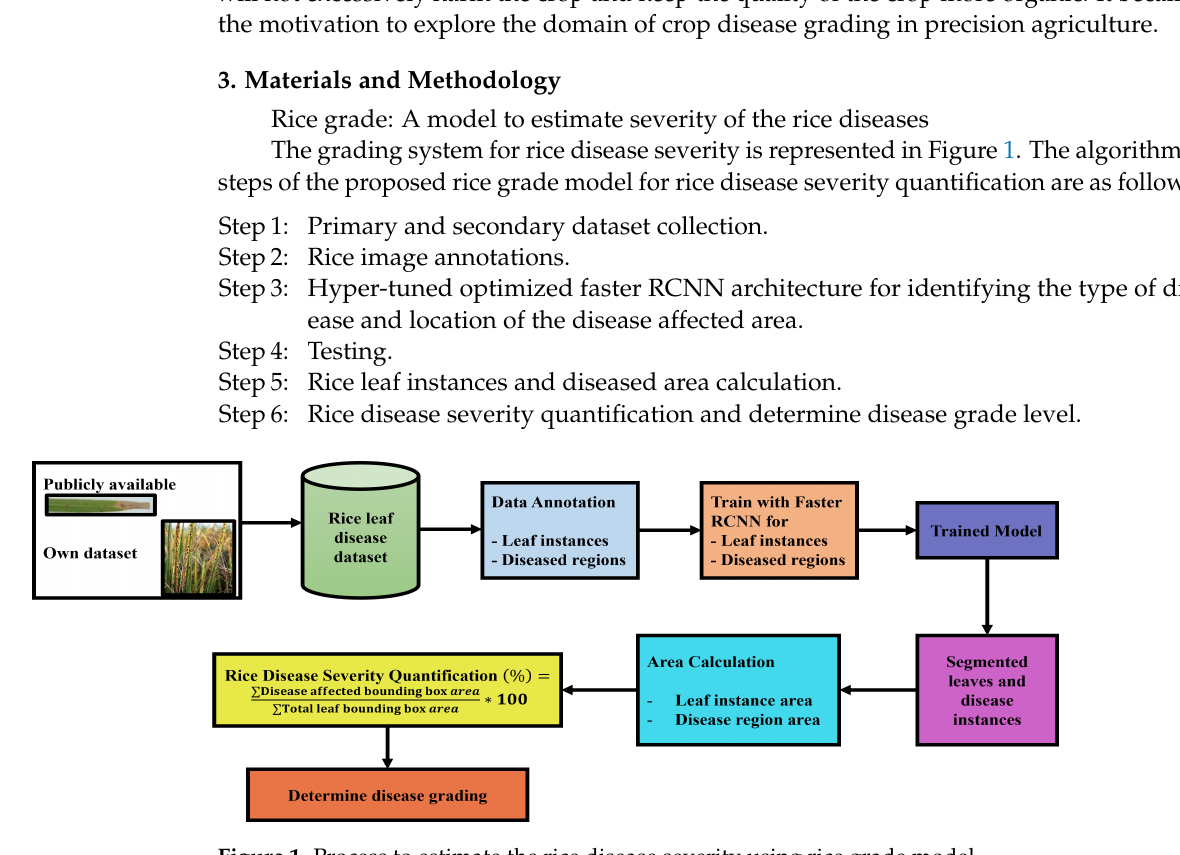
Figure 1. Process to estimate the rice disease severity using rice grade